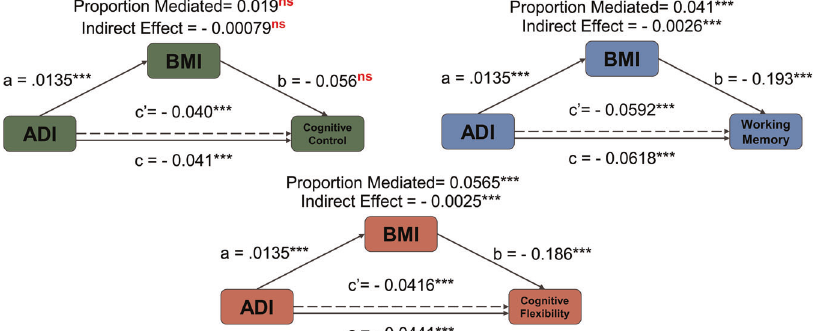
Fig. 4 Mediation models of demonstrating indirect effect of BMI in the relationship between ADI and neurocognitive subtests. Model Characteristics are identical to those described in Fig. 3, without insets. The indirect effects of BMI are signi fi cant for the Card Sort and List Sort tasks, but not for the Flanker